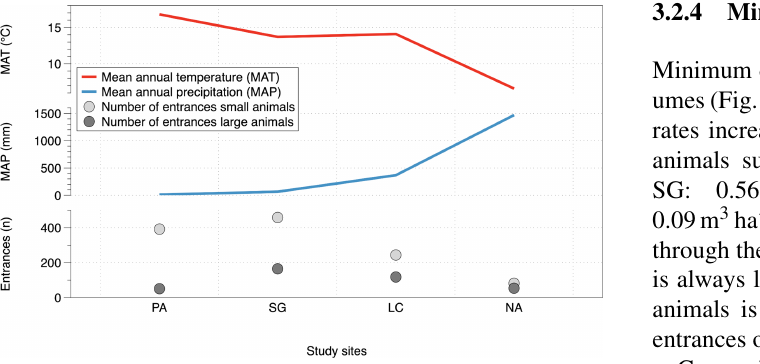
Figure 10. Mean annual temperature (MAT) and mean annual pre- cipitation (MAP) and animal burrow entrance distribution along the climatic gradient; the depicted data are pooled from all three field campaigns: 2016, 2017 and 2018; MAT and MAP from Fick and Hijmans (2017). PA – NP Pan de Azúcar, SG – Santa Gracia, LC – NP La Campana, NA – NP Nahuelbuta. (Note that in PA the sum of the south-facing plot entrances is one plot, and the north-facing entrance sum is three